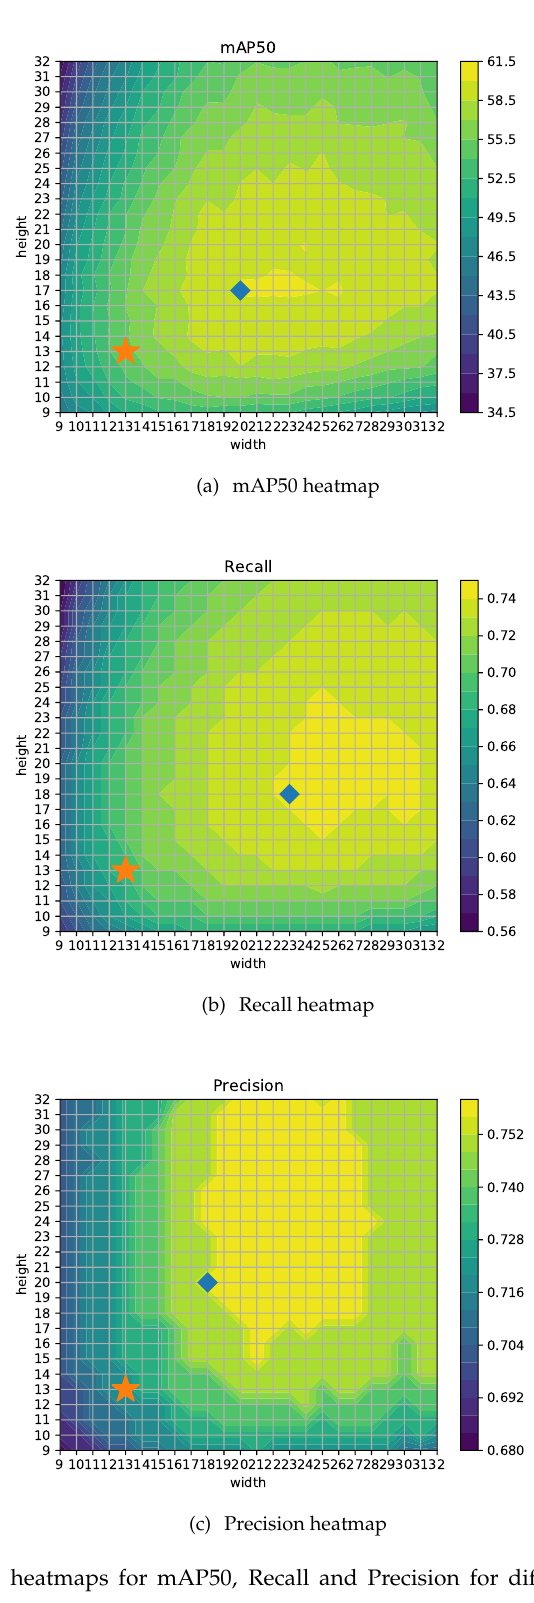
Figure 8. YOLOv4: heatmaps for mAP50, Recall and Precision for different width and height grid